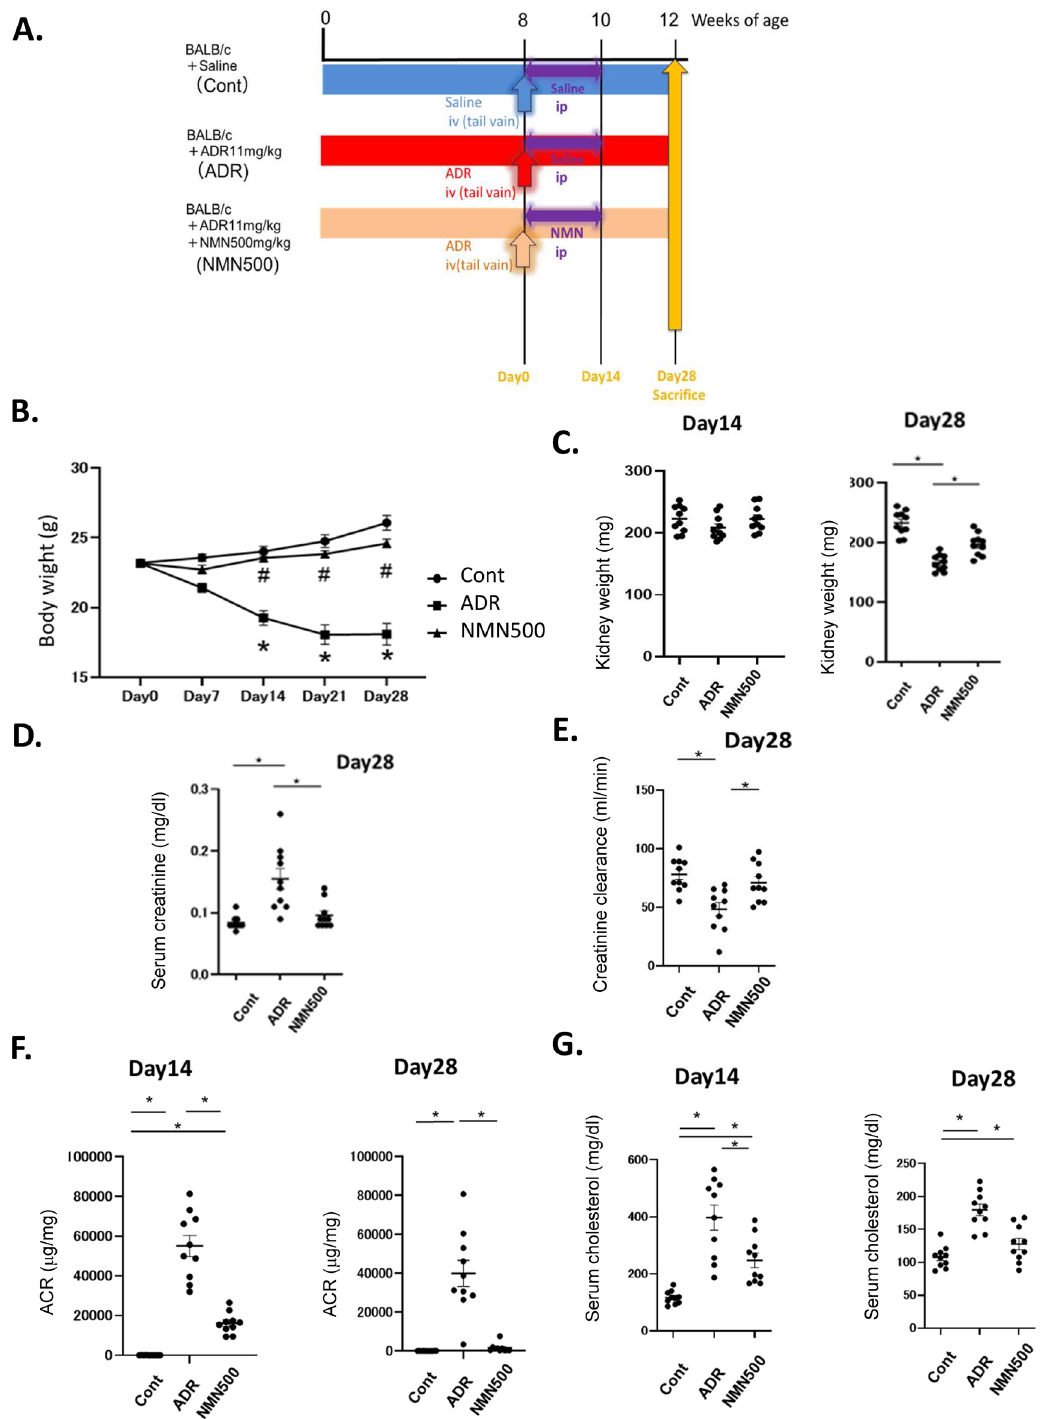
Figure2. Effect of short-term NMN treatment on kidney functions and survival. ( A ) Schematic diagram of the NMN treatment protocol. ( B ) Temporal changes in the body weights of the mice in the three groups (Cont, ADR , and NMN500; n = 10). * P < 0.05 Cont vs. ADR. † P < 0.05 Cont vs. NMN500. ( C ) The weights of the kidneys on days 14 and 28 in the three groups (Cont, ADR , and NMN500; n = 10). ( D ) Serum creatinine levels were measured on day 28 in the three groups (Cont, ADR , and NMN500; n = 10). ( E ) Creatinine clearance on day 28 in the three groups (Cont, ADR , and NMN500; n = 10). ( F ) Urine ACR on day 14 (n = 10) and 28 (n = 10) in the three groups (Cont, ADR , and NMN500). ( G ) Serum cholesterol levels on day 14 (n = 10), and 28 (n = 10) in the three groups (Cont, ADR , and